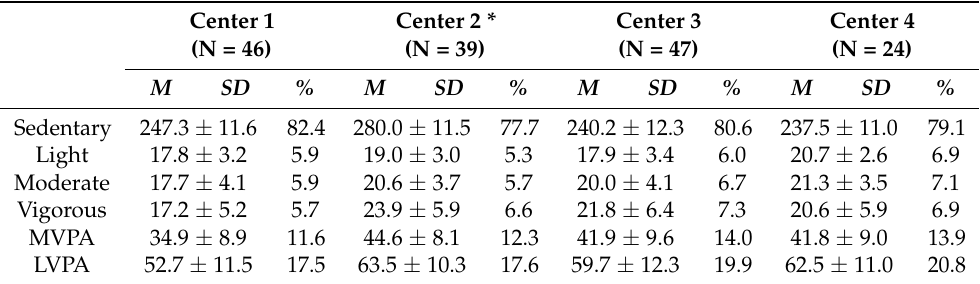
Table 1. Daily PA in minutes and percentage performed by students during school hours.